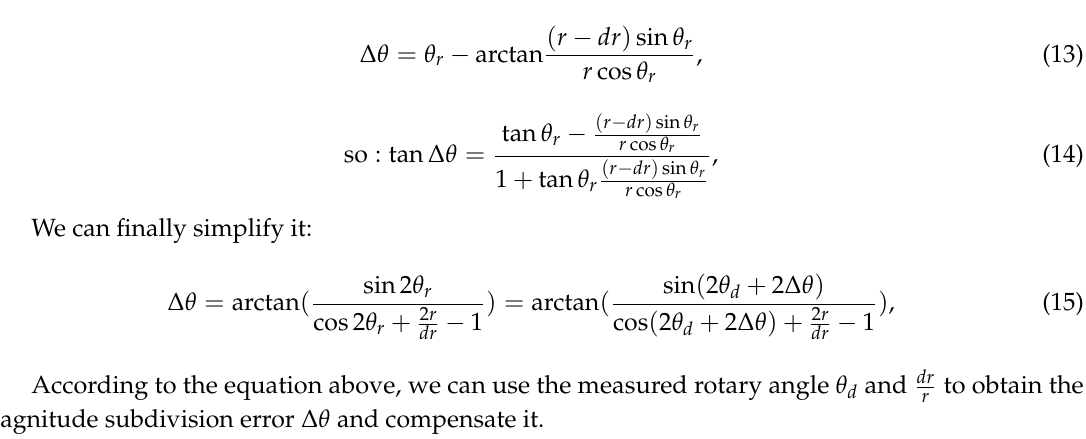
Figure 1. Distribution law of D